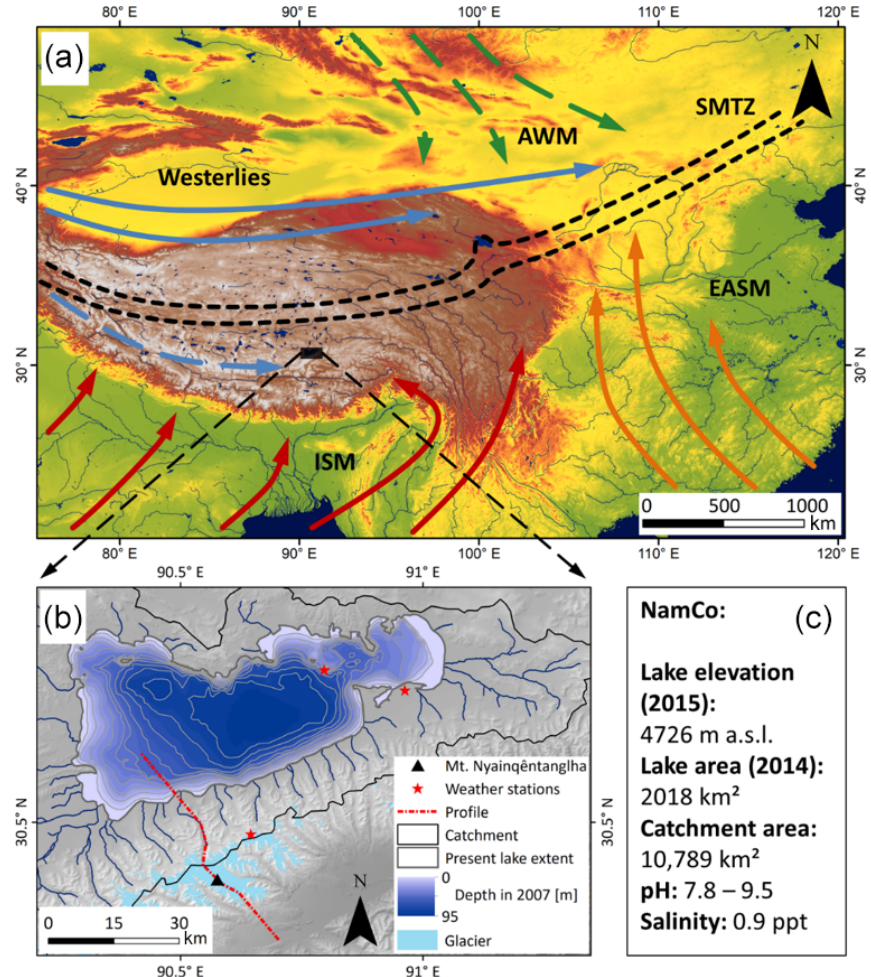
Figure 1. Major atmospheric systems governing the climate in China (a) . The Nam Co study site (b) . Characteristics of Nam Co’s catch- ment (c) . (a) Continuous arrows indicate systems active in summer. These are the Indian Summer Monsoon (ISM) in red, the East Asian Summer Monsoon (EASM) in orange and the westerlies in blue. Dashed arrows represent systems active in winter. These are the Asian Win- ter Monsoon (AWM) in green and southern parts of the westerlies in blue. The dotted black lines denote the Summer Monsoon Transition Zone (SMTZ) (following Wünnemann et al., 2018). Background elevation data according to SRTM digital elevation model v4 (Jarvis et al., 2008). (b) Nam Co catchment, including the current lake extent (based on Copernicus Sentinel data 2018, processed by ESA), its bathymetric depth in 2007 (Wang et al., 2009a), the outline of the catchment (following Keil et al., 2010), glaciers of the Nyainqêntanglha Range (GLIMS and NSDIC 2005, updated 2018) and rivers discharging into Nam Co (SRTM digital elevation model v4; Jarvis et al., 2008). The dotted red line indicates the profile position of Fig. 2. (c) Characteristics of Nam Co: lake elevation (Jiang et al., 2017), lake surface area (Zhang et al., 2017), catchment area, lake pH and salinity (Keil et al.,